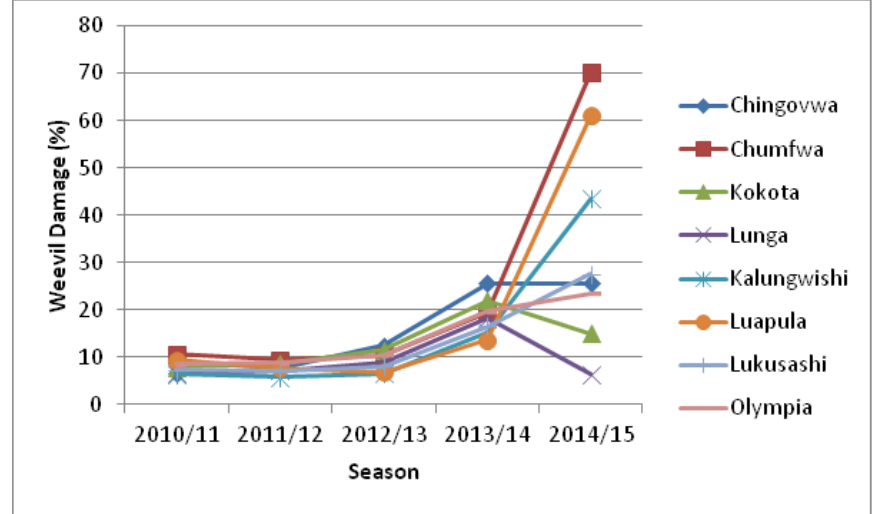
Figure 2: Variability in tolerance to weevil damage among sweetpotato genotypes in different